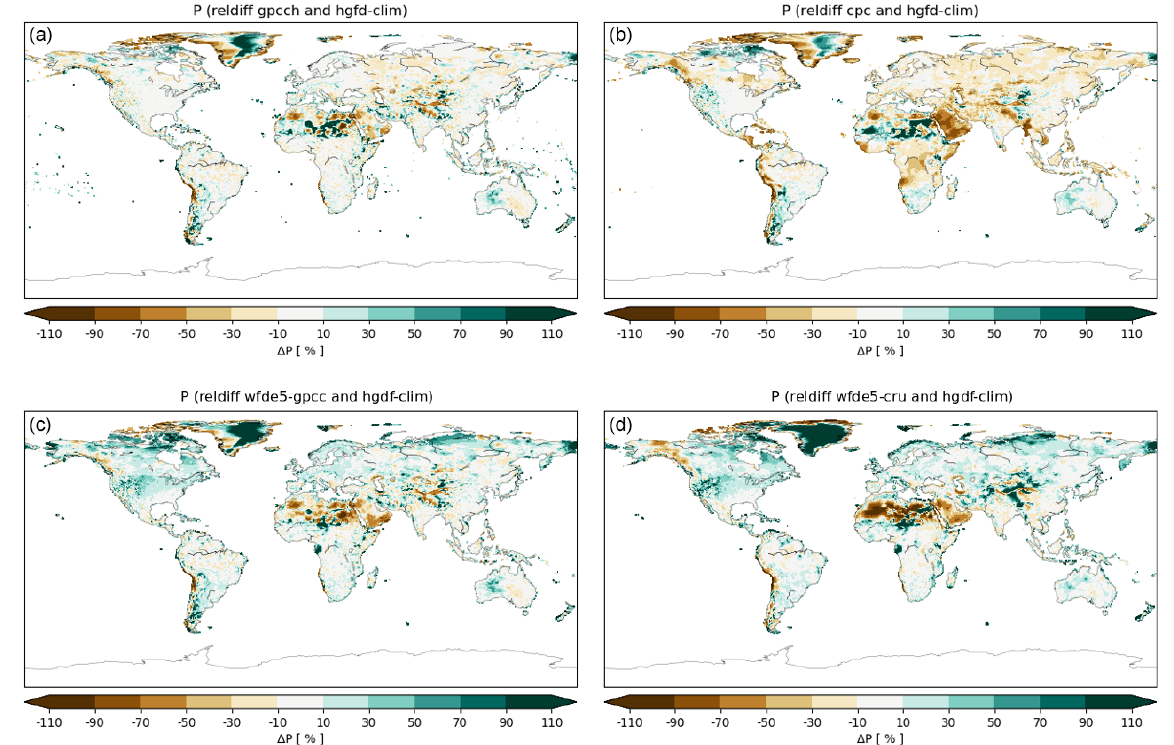
Figure 5. Relative difference in data sets to the HydroGFD3 annual mean P climatology for the period 1980–2009; gpcch (a) , cpcp (b) , wfde5-gpcc (c) , and wfde5-cru (d)